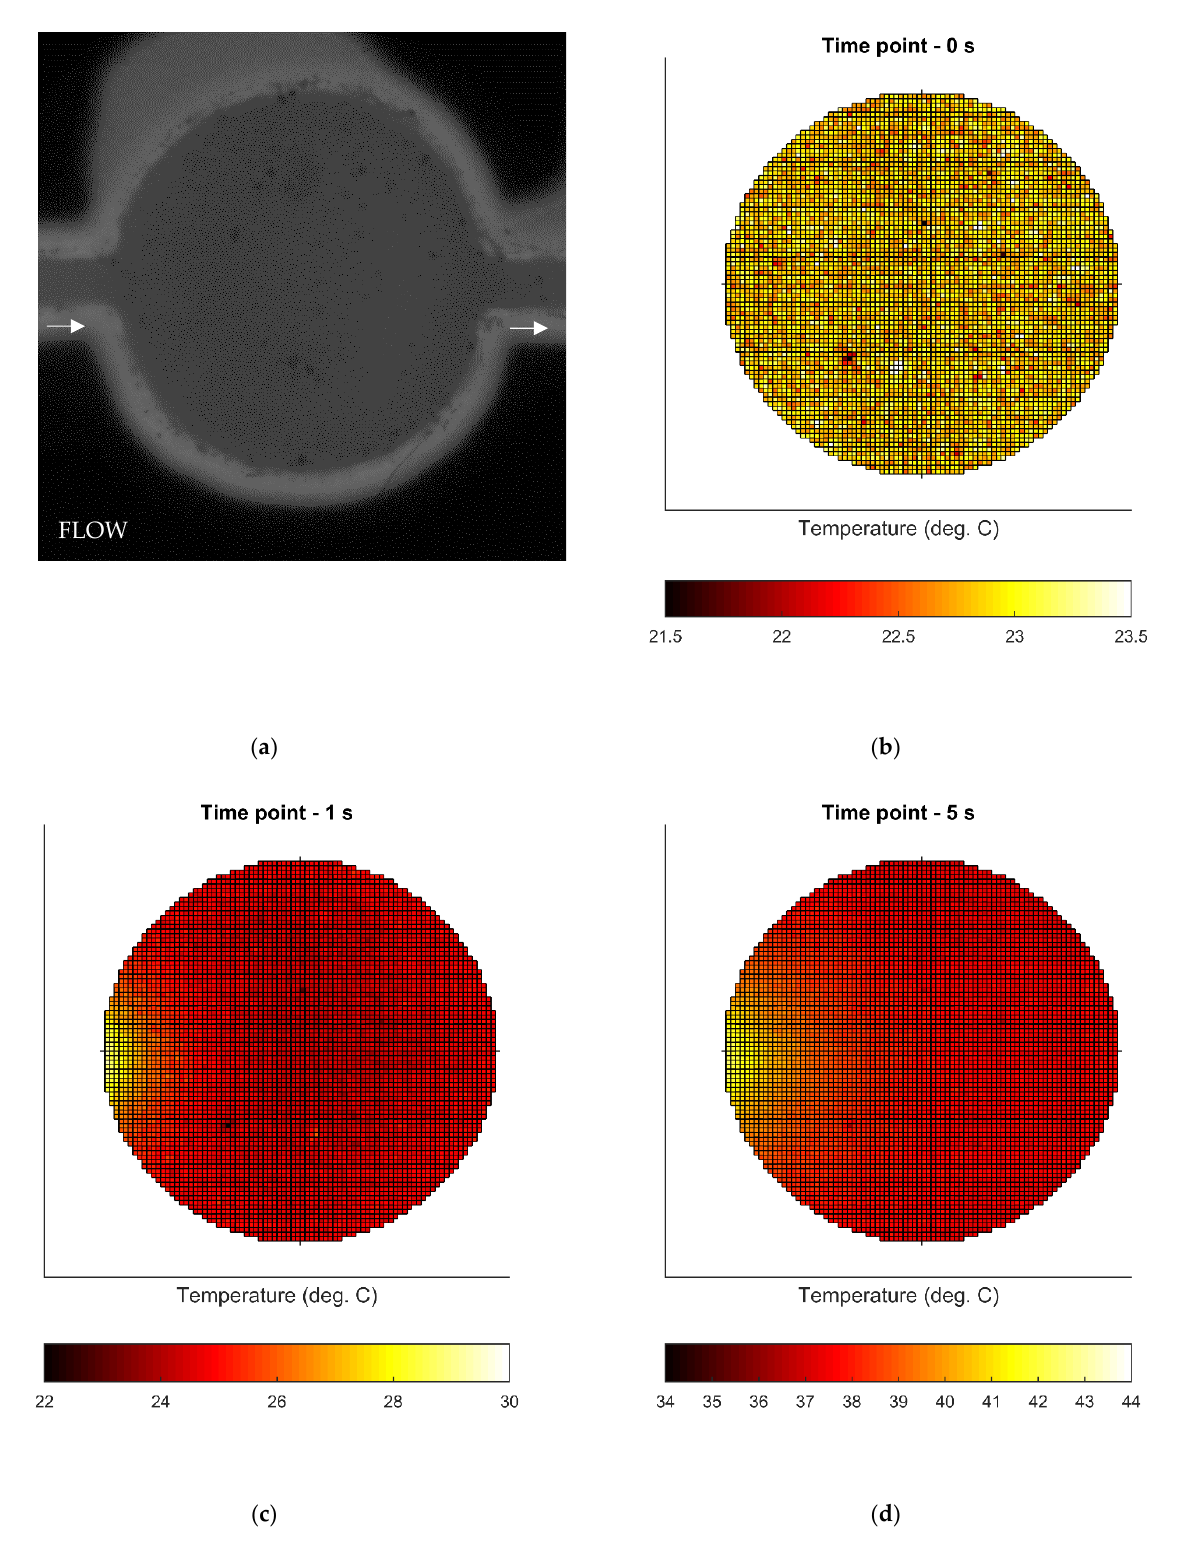
Figure 9. The 10 µ L/min flow scenario. ( a ) The image of the fluorescent liquid loaded into the microwell before heating. ( b ) The temperature profile of the mixture in the microwell before heating. ( c ) The temperature profile of the mixture in the microwell after 1 s of heating. ( d ) The temperature profile of the mixture in the microwell after 5 s of heating.